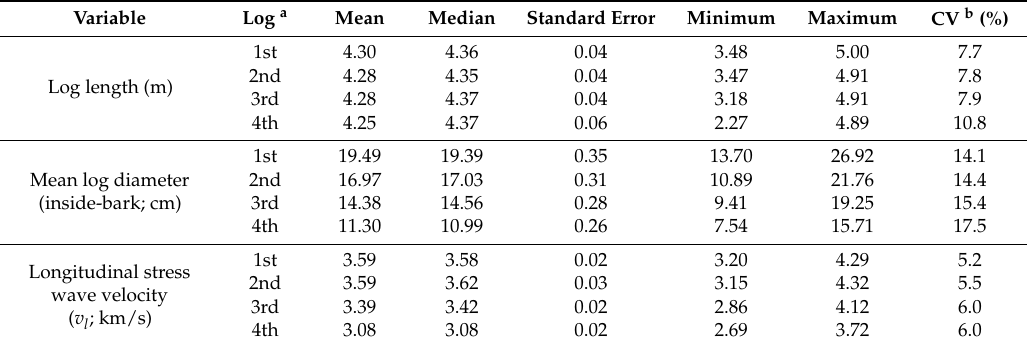
Table 4. Descriptive statistical summary of the dimensions of the 243 sample logs and associated acoustic velocity measurements by log position ( n = 243 of which 61, 61, 61 and 60 were first, second, third and fourth positioned logs,